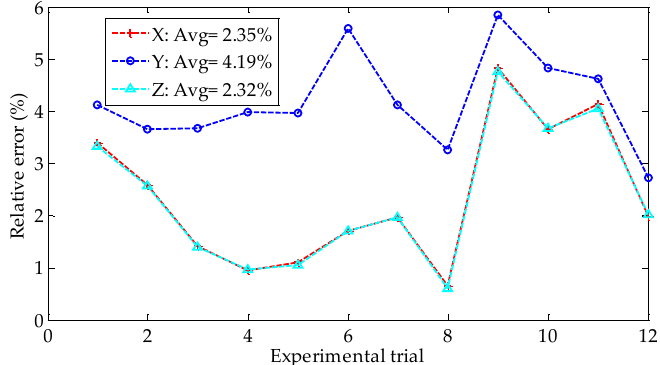
Figure 14. The relative error of the 3D coordinates.